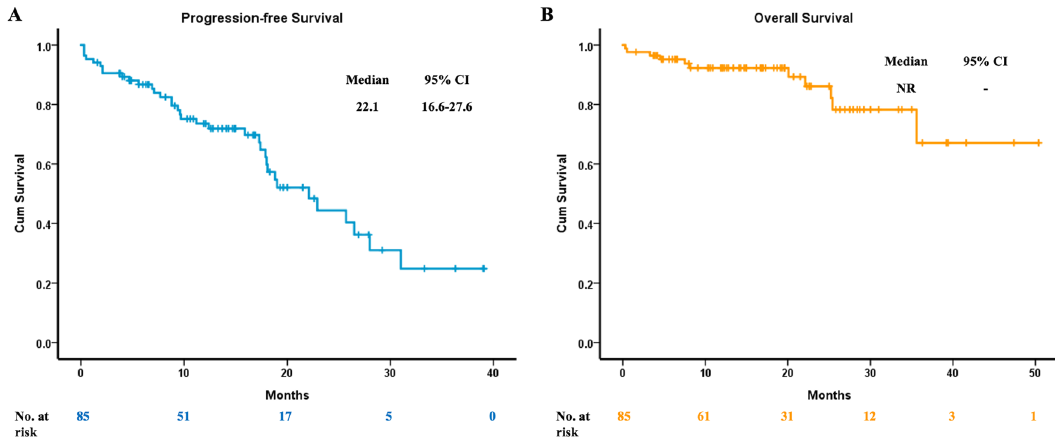
Figure 1. The clinical efficacy of osimertinib in advanced EGFR -mutant NSCLC patients. ( A ) The median progression-free survival. ( B ) The median overall survival. EGFR, epidermal growth factor receptor; NSCLC, non-small-cell lung